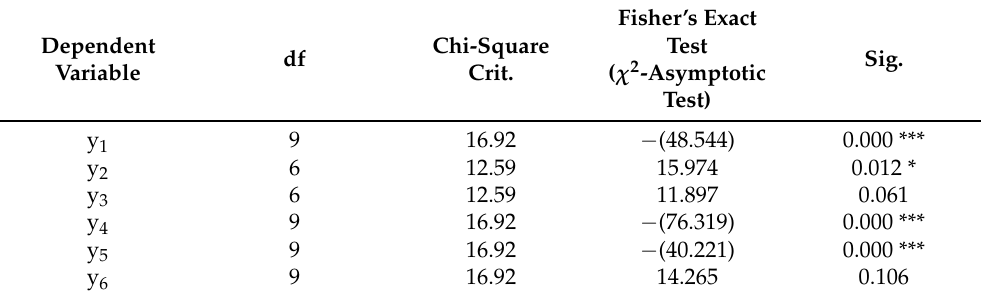
Table 3. Fisher’s exact test values depending on company size, data for whole